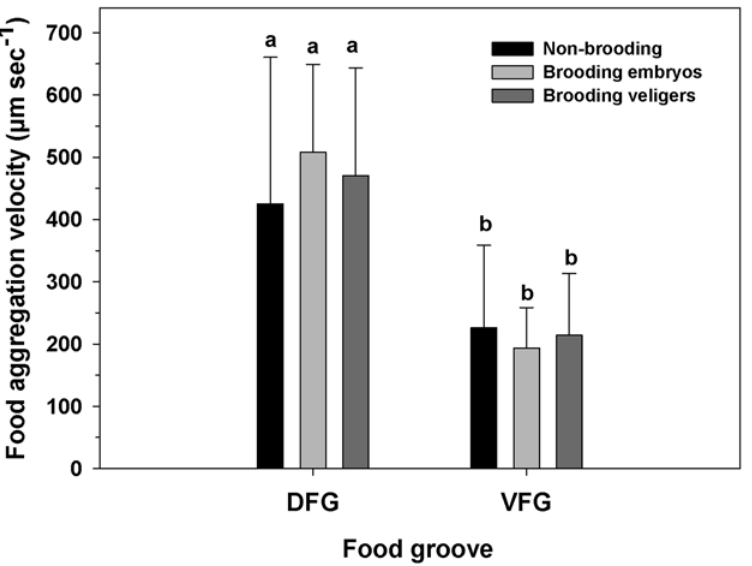
Fig 6. Ostrea chilensis. Velocity of food particles in the food grooves of oyster females that were not- brooding, brooding embryos, or brooding veligers during the reproductive period. DFG: Dorsal food groove; VFG: Ventral food groove. Different letters above the bars indicate significant differences (p < 0.05); mean + SD